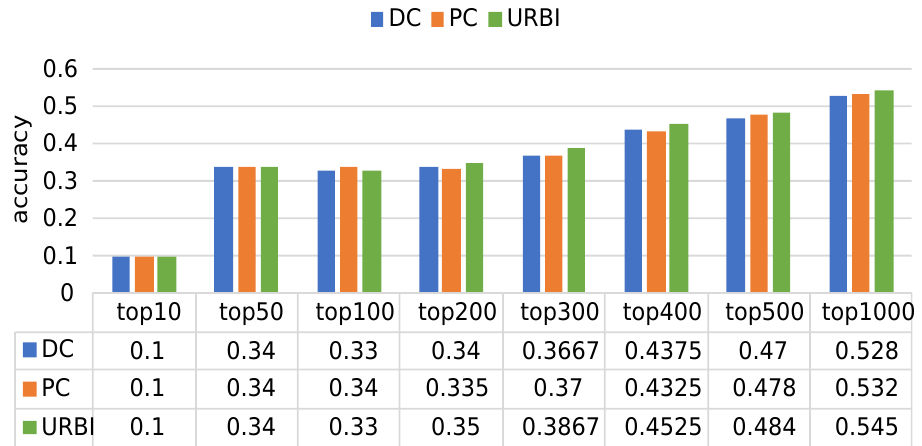
Figure 15. This figure depicts the experimental results of dataset No.15, which contains 9128 book